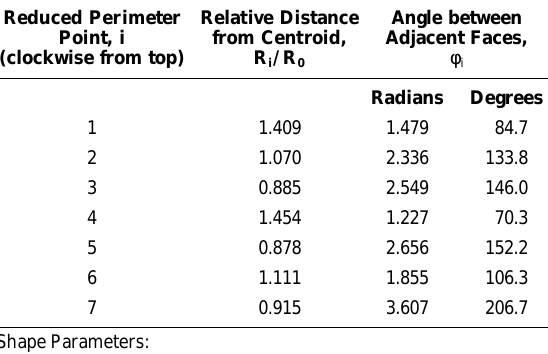
Shape Parameters: Elongation, E: Angular Variability, V φ :